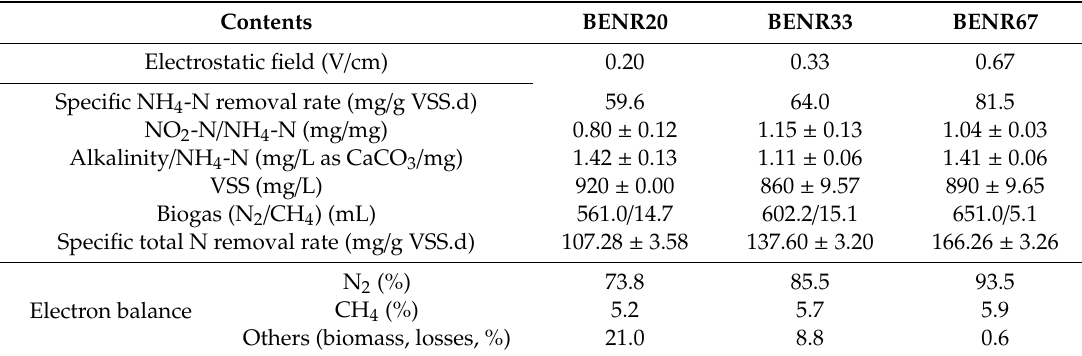
Table 1. Performance of bioelectrochemical nitrogen removal depending on the electrostatic field.